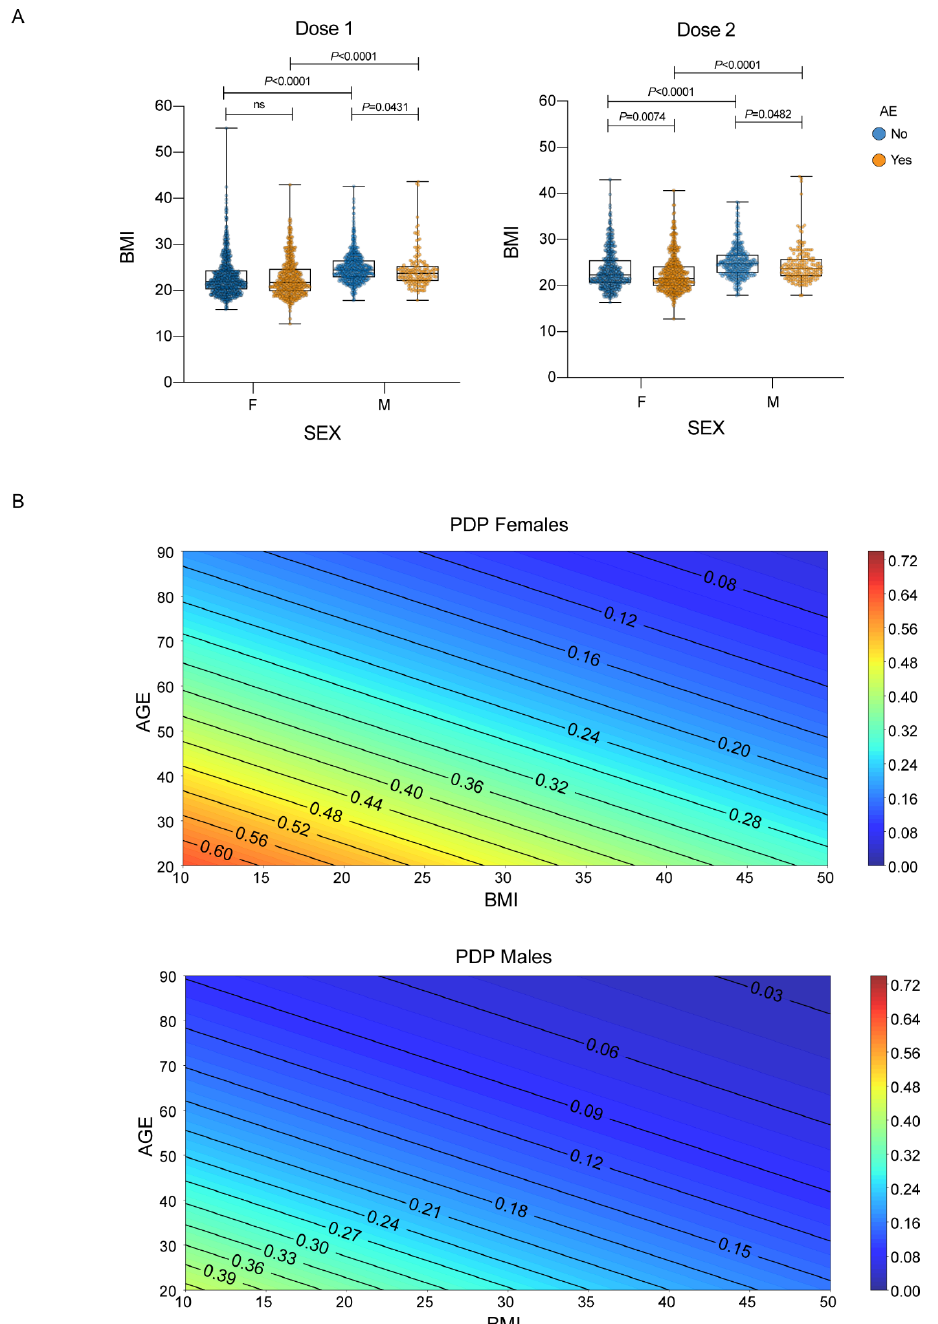
Figure 1. Sex, age, and BMI and their association with AE. ( A ) BMI distributions stratified by sex and any adverse events. Each dot corresponds to an individual subject. The box plots show the interquartile range, the horizontal lines show the median values, and the whiskers indicate the minimum-to-maximum range. p -values were calculated using Kruskal–Wallis test, as data were not normally distributed according to Shapiro–Wilk test, followed by Dunn’s test after the first and second dose; ( B ) Partial dependence plots of the logistic regression model (with age, sex and BMI as covariates) showing the probability of having either a mild AE for 7 or more days or a severe AE of any duration after the second dose of vaccine stratified by sex. Female subjects show higher risk at the same age and